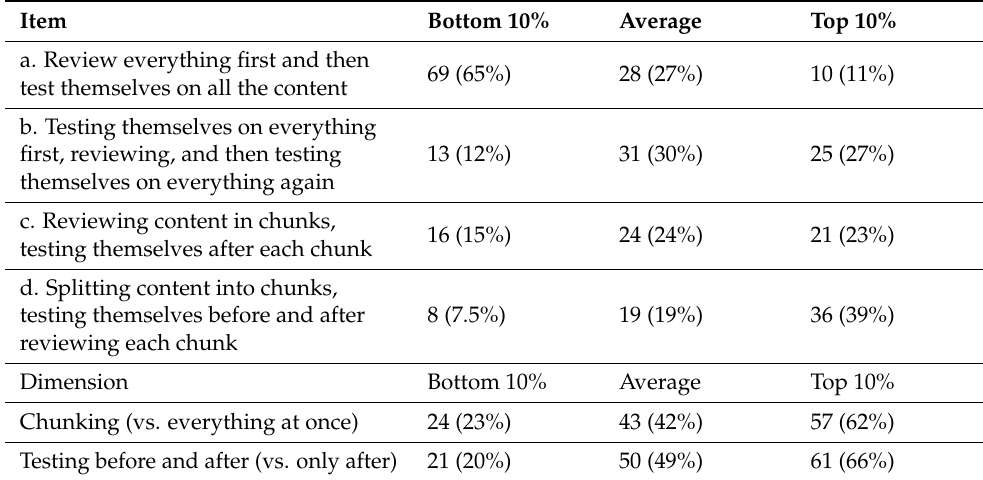
Table 3. Use of Testing: Frequency and Percentage of Responses by Condition.